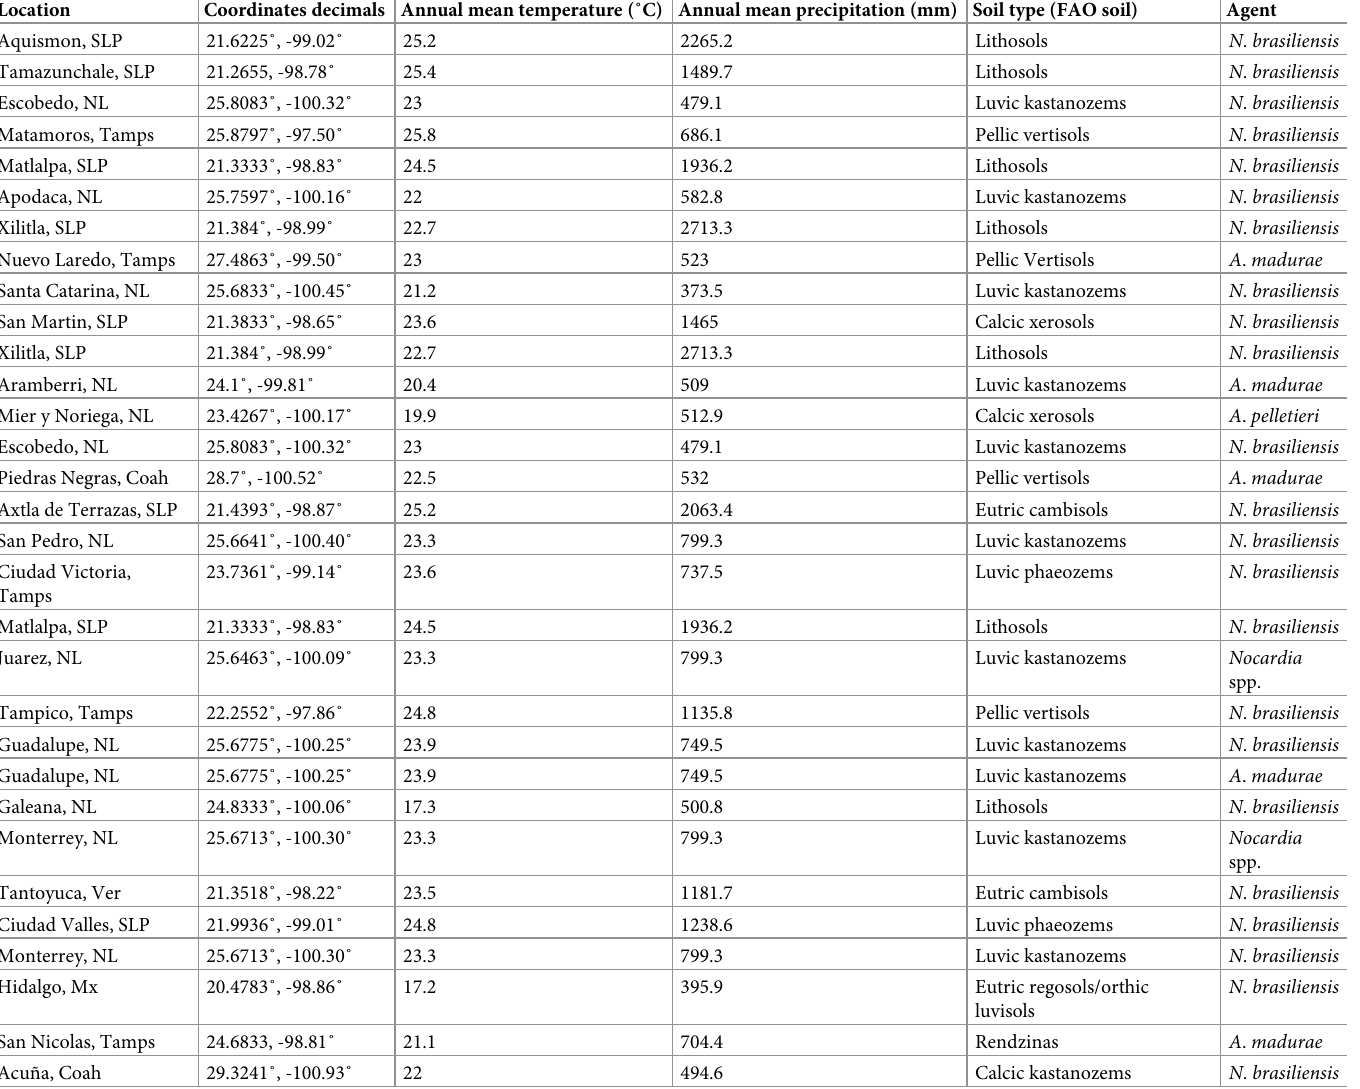
Table 1. Location, climate, soil type, and etiological agent of mycetoma cases from San Luis Potosı´(SLP), Nuevo Leon (NL), Tamaulipas (Tamps), and Coahuila (Coah).